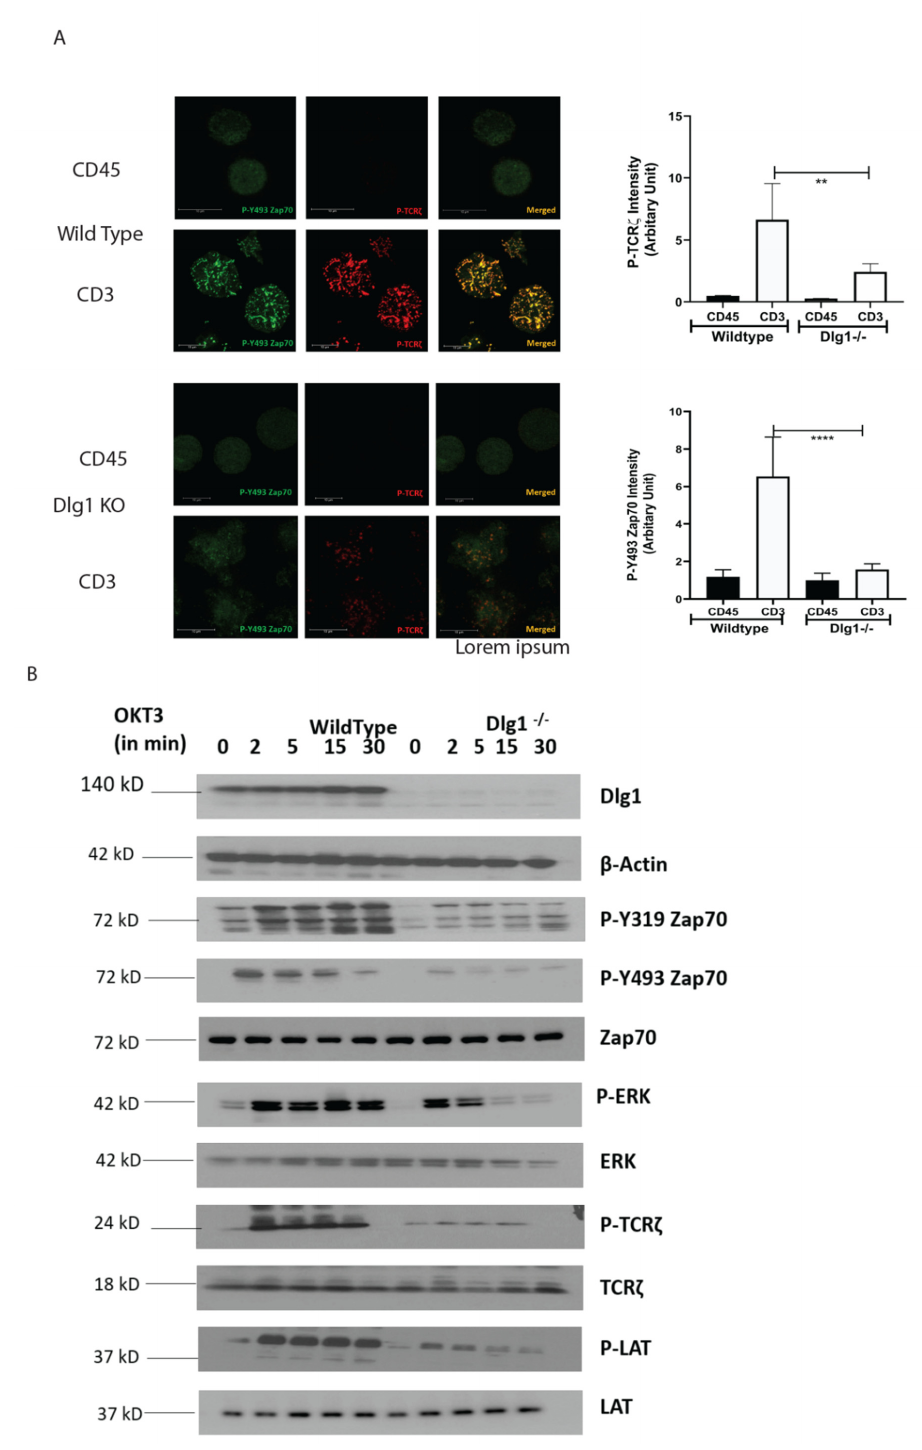
Figure 2. DLG1 knockout inhibits TCR-MC formation and T cell signaling ( A ). Microclusters of phosphorylated Y493 ZAP-70 (green) and phosphorylated TCR- ζ (red) in immunostained wild-type or DLG1 KO Jurkat cells were visualized 5 min after the cells were dropped onto coverslips coated with anti-CD3 (stimulated) or anti-CD45 (unstimulated). Scale bars, 10 µ m. Quantitative data for specific signals’ intensities (using Image J; collected from eight fields) are graphically represented. ( B ). Immunoblot analysis of lysates from wild-type and DLG1 KO Jurkat cells activated with soluble anti- CD3 (monoclonal antibody OKT3) and antibody to mouse immunoglobulin G (IgG). Blots were probed for the indicated phosphorylated and total proteins. Data are representative of three experiments. Student’s unpaired t tests were used for ( A ). ** p < 0.01, **** p <